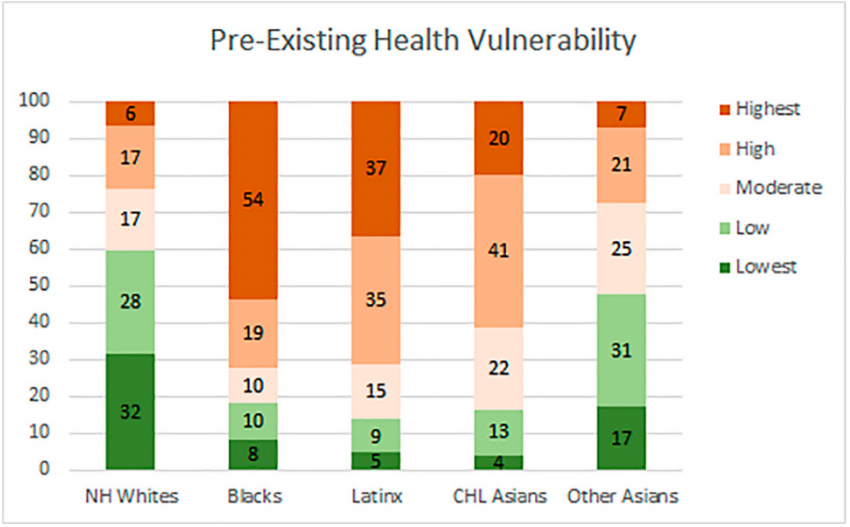
Figure 6. Ethnoracial Distribution by pre-existing health vulnerability.